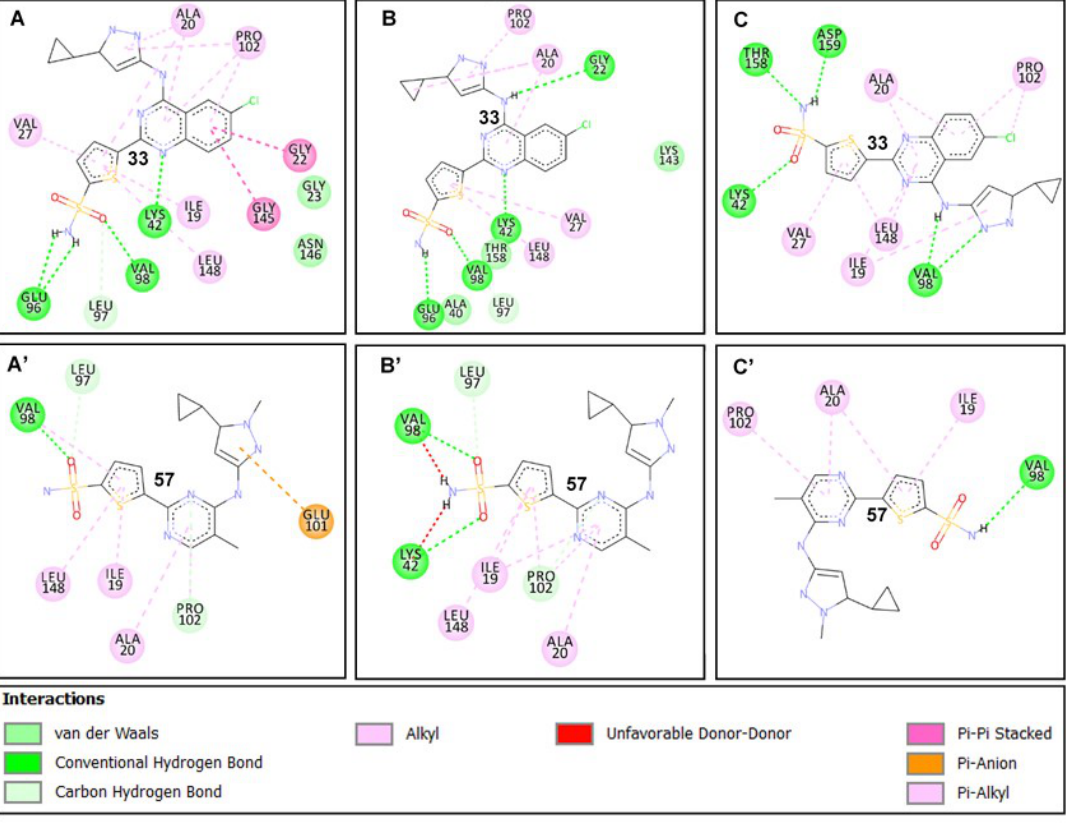
Figure 8. Comparative binding dynamics of compounds 33 and 57 at the NBP of PknA across post-equilibrated trajectories 170-200ns ( A ) 33-PknA at 170 ns. ( B ) 33-PknA at 190 ns ( C ) 33-PknA at 200ns. ( A’ ) 57-PknA at 170 ns. ( B’ ) 57-PknA at 190 ns. ( C’ ) 57-PknA at 200 ns. Favorable and unfavorable interactions that characterize the binding of the ligands are shown and are well represented by their respective legends.